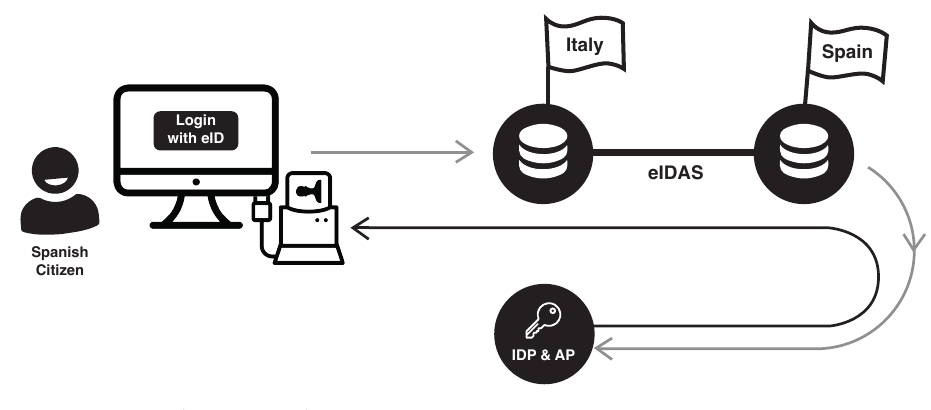
Figure 1. eIDAS basis example.